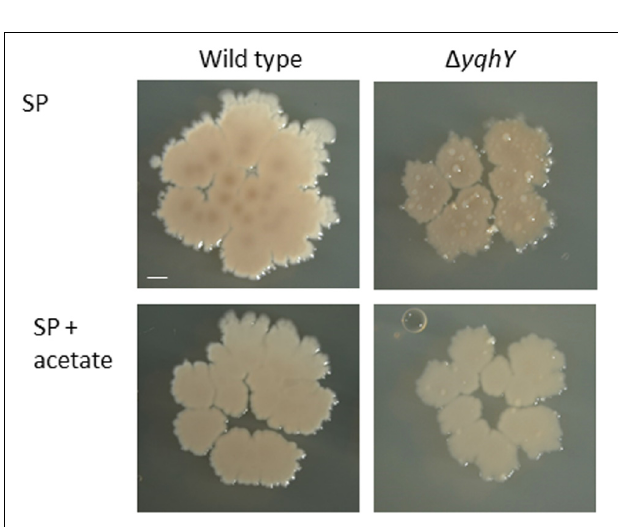
FIGURE 6 | Effect of acetate on the yqhY mutant. The wild type strain 168 and the isogenic yqhY mutant GP1468 were cultivated on SP plates without or with added acetate (0.5%). Scale bar, 1